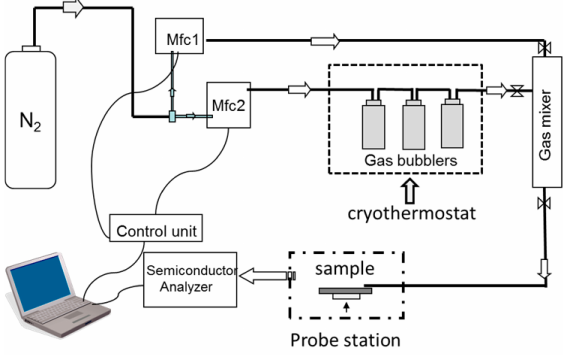
Figure 2. Schematic illustration of the gas sensing